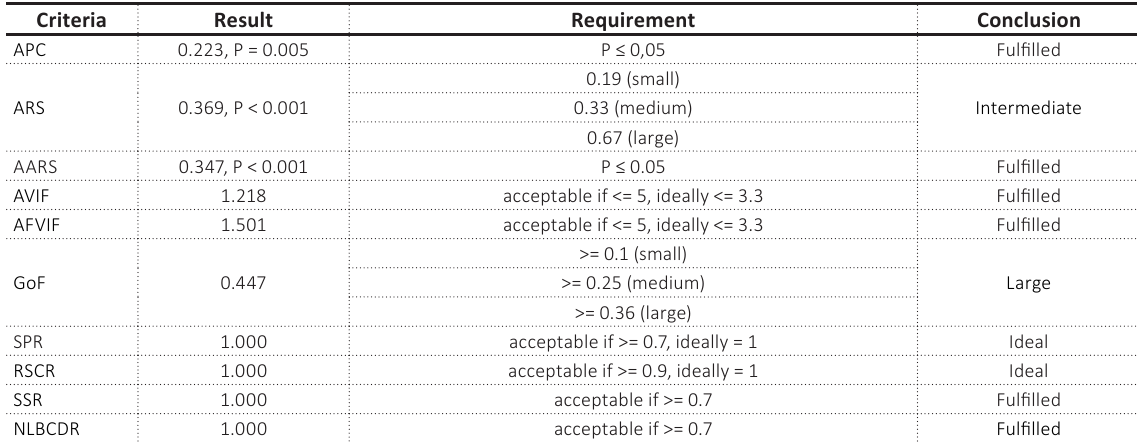
Table 1. Warp PLS model